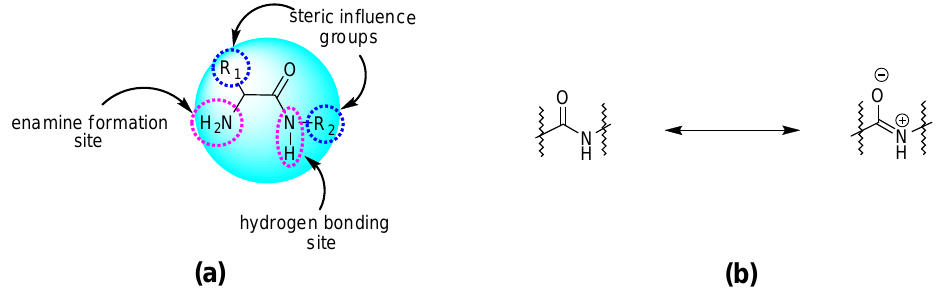
Scheme 2. ( a ) Multifunctional activity of amino amide scaffolds. ( b ) Resonance structure of amide